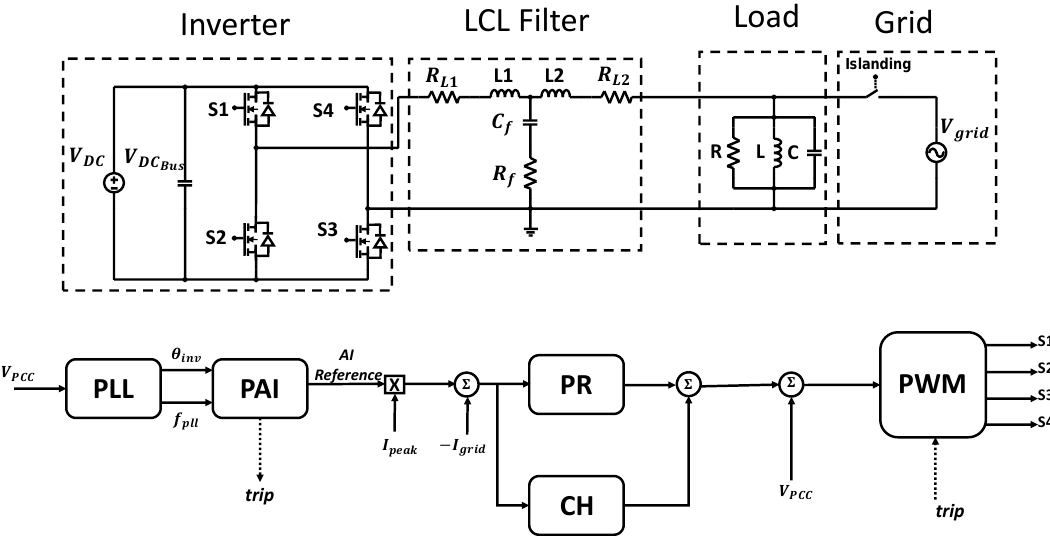
Figure 11. Block diagram of the power and control structures.